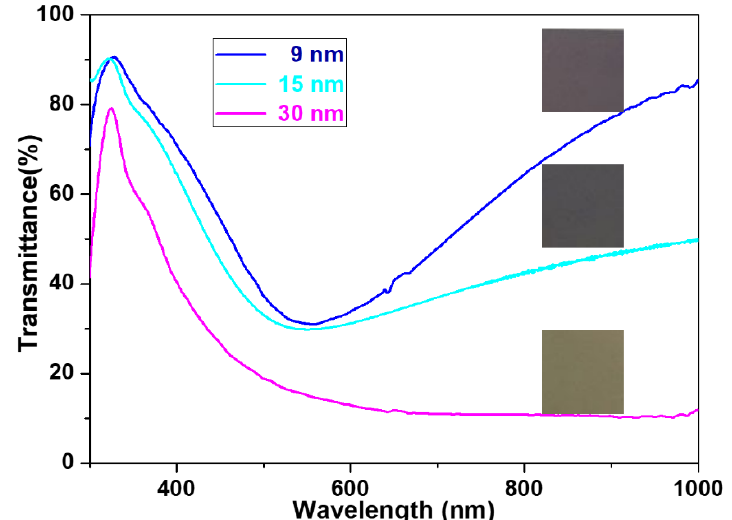
Figure 4. Transmittance of Ag covers immobilized on glass slides with di ff erent thicknesses. The squares on the right panel of the figure show photographs of corresponding Ag covers with di ff erent